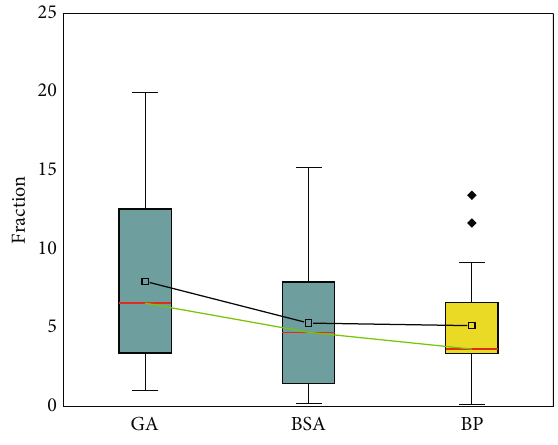
Figure 7: The box diagram of